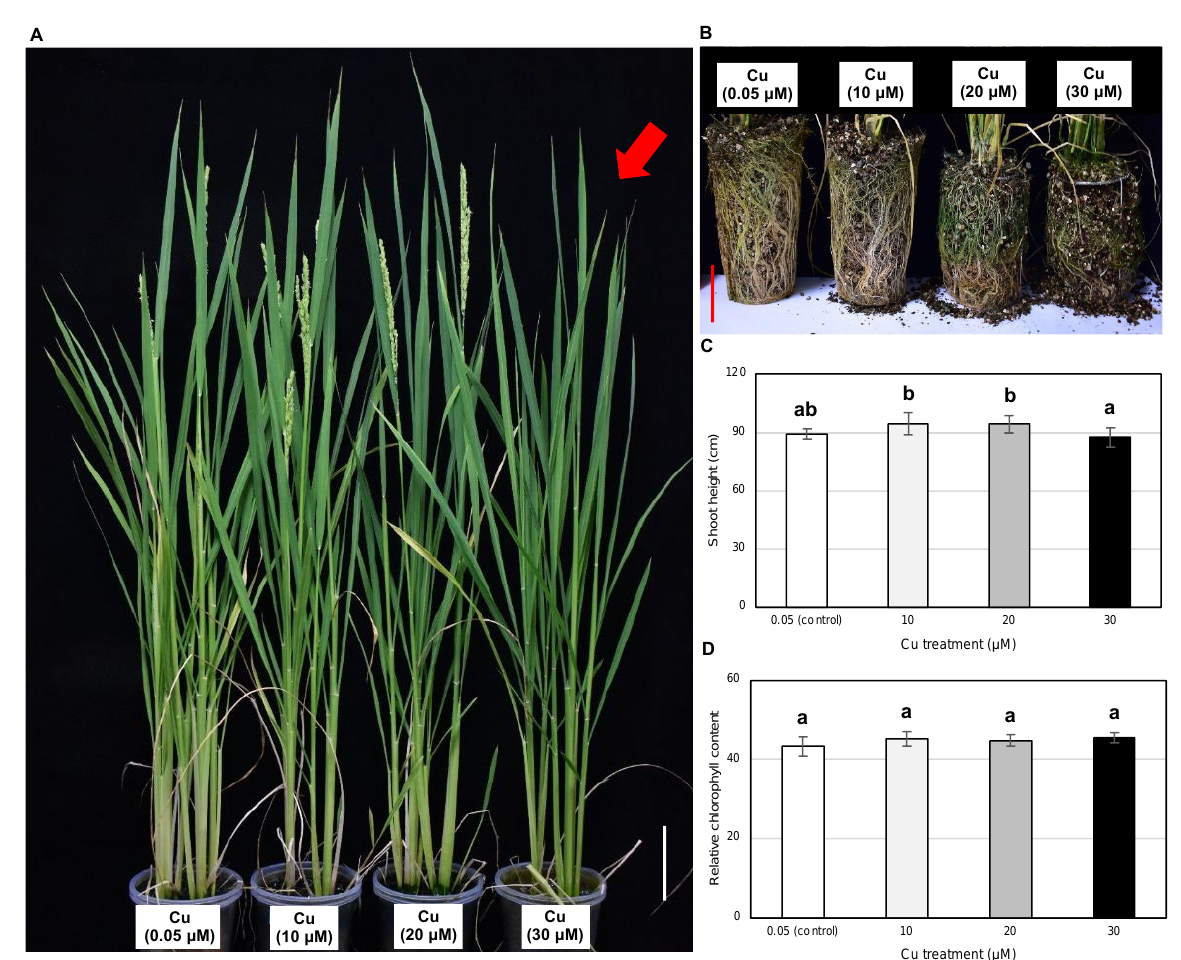
Figure 4. Effects of 10, 20 and 30 µM Cu on the physiology of rice plants at the reproductive stage: ( A ) Shoot morphology during heading (scale bar = 10 cm); ( B ) root morphology (scale bar = 5 cm); ( C ) shoot height and ( D ) relative chlorophyll content (SPAD) are shown. Data are means ± SD (shoot height, n = 8; relative chlorophyll content, n = 4). Red arrow indicates delayed heading in a plant exposed to 30 µM Cu. One-way ANOVA and Tukey’s post hoc test were used, with different letters denoting a significant difference ( p < 0.05). Table 1. Effect of Cu and Fe treatments on the yield components of rice. Grain yield is the product of panicle number per plant, grain number per panicle and the thousand grain weight/1000. For each yield component, the data are means ± SD ( n = 8), with significance determined by one-way ANOVA followed by Tukey’s post hoc test ( p < 0.05, as denoted by different letters).